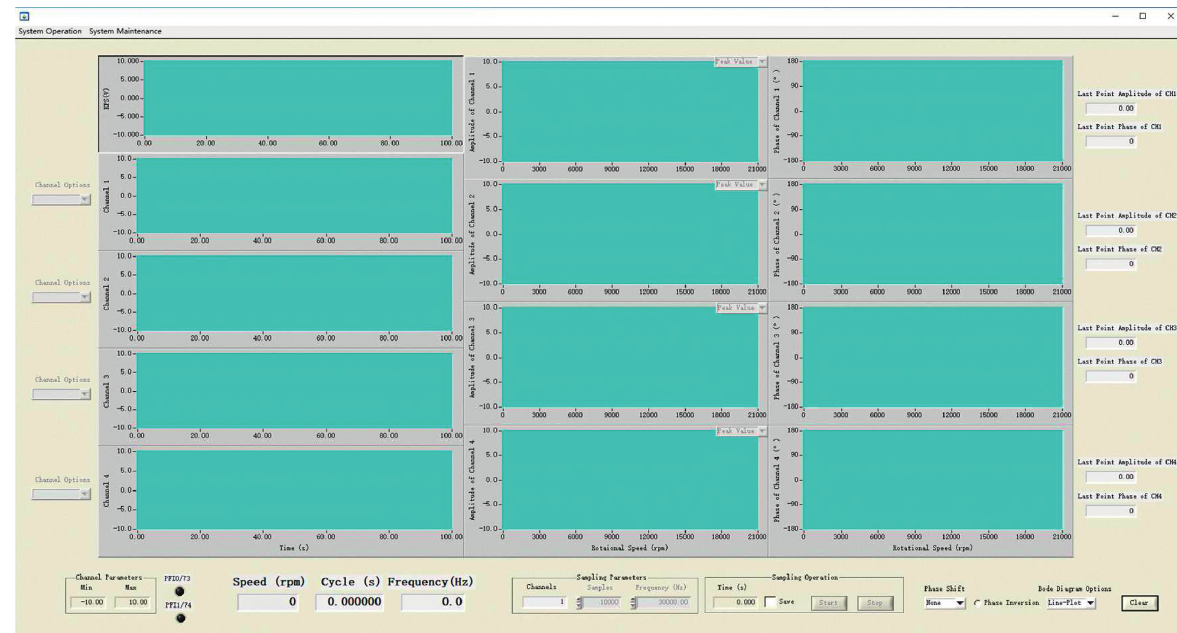
Figure 6: The data acquisition interface of testing system